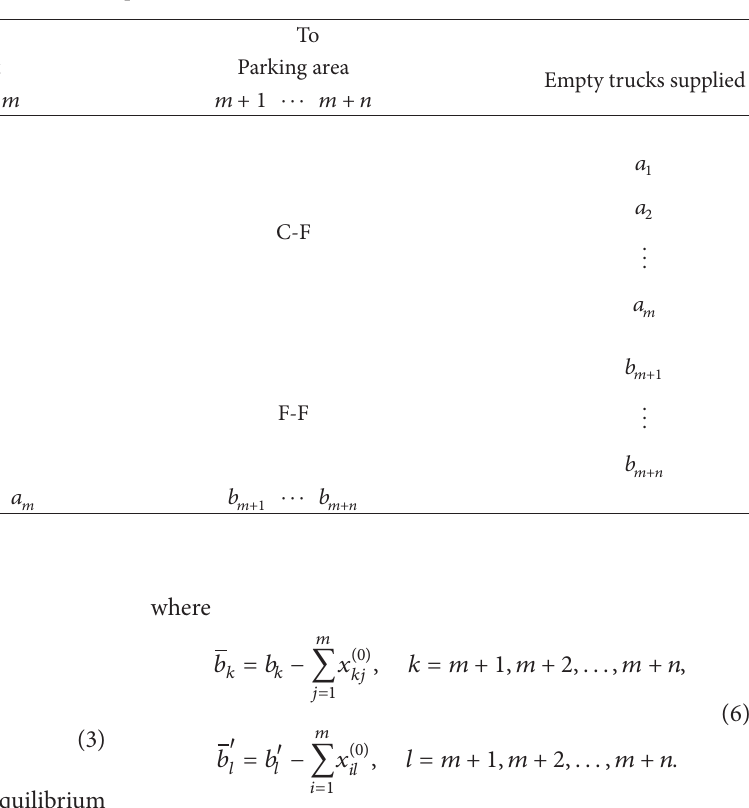
Table 1: Transportation